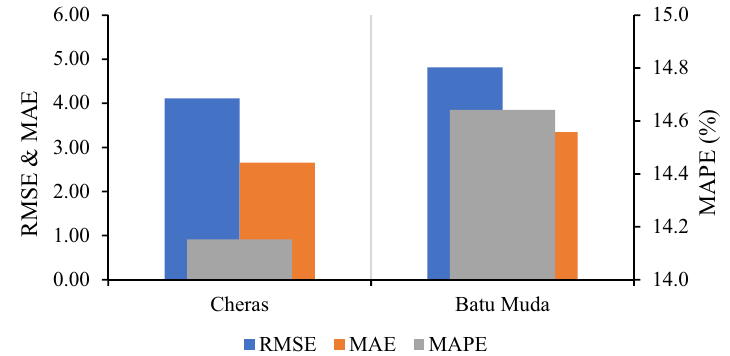
Figure 6. Evaluation error of EEMD-LSTM for Cheras and Batu Muda station.